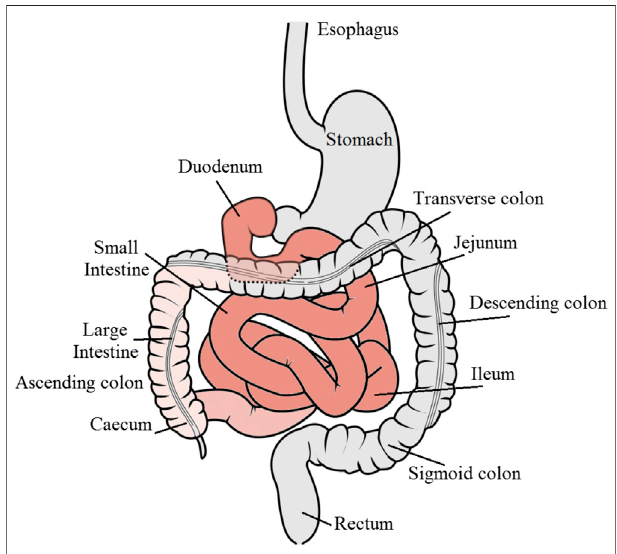
FIGURE 1 | Schematic diagram of the gastrointestinal tract showing the major regions for drug absorption denoted in red color. GI tract diagram by Olek Remesz (https://commons.wikimedia.org/wiki/File:GISystem.svg), under a Creative Commons license.